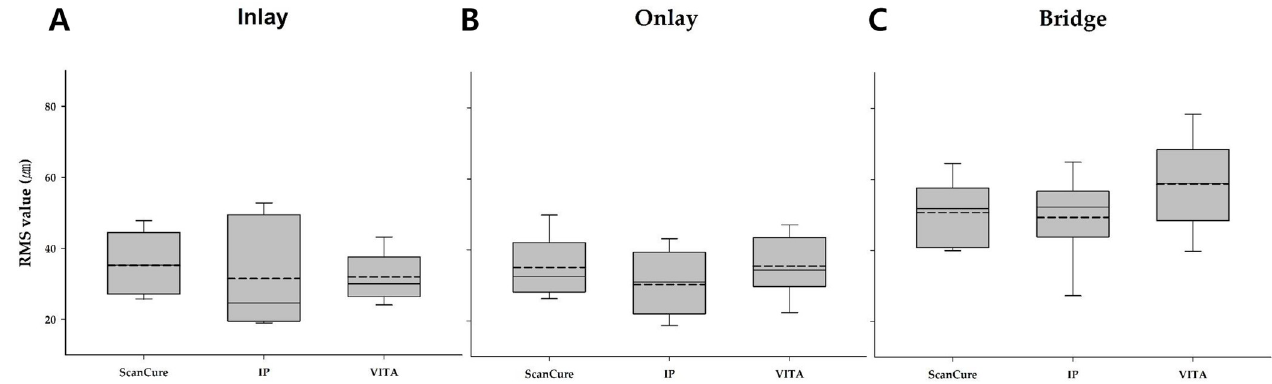
Fig 7. Designs of ejection nozzle and spraying hole in powder-type agents. A—without ejection nozzle in VITA; B—with ejection nozzle in VITA; C— spraying hole in VITA; D—without ejection nozzle in IP; E—with ejection nozzle in IP; F—spraying hole in